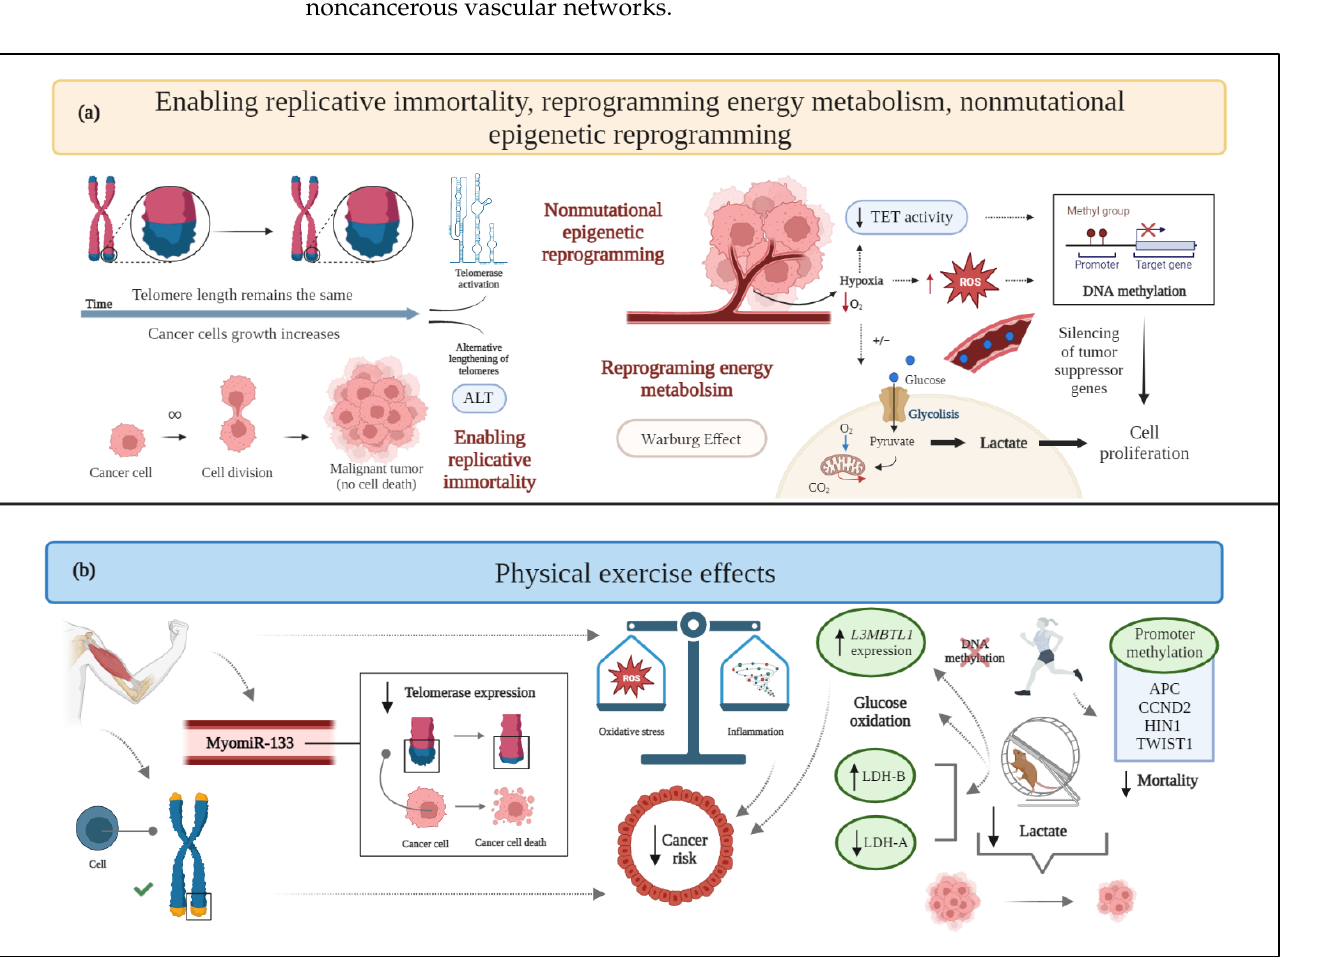
Figure 3. ( a ) Schematic drawing of cancer hallmarks, highlighting markers related to enabling replicative immortality, reprogramming energy metabolism, and nonmutational epigenetic repro- gramming. ( b ) The effects of physical exercise on enabling replicative immortality, reprogramming energy metabolism, and nonmutational epigenetic reprogramming. ALT: alternative lengthening of telomeres; APC: adenomatous polyposis coli; CO 2 : carbon dioxide; CCND2: cyclin D2; HIN1: high in normal-1; L3MBTL1: lethal(3) malignant brain tumor-like 1; LDH-A: lactate dehy-